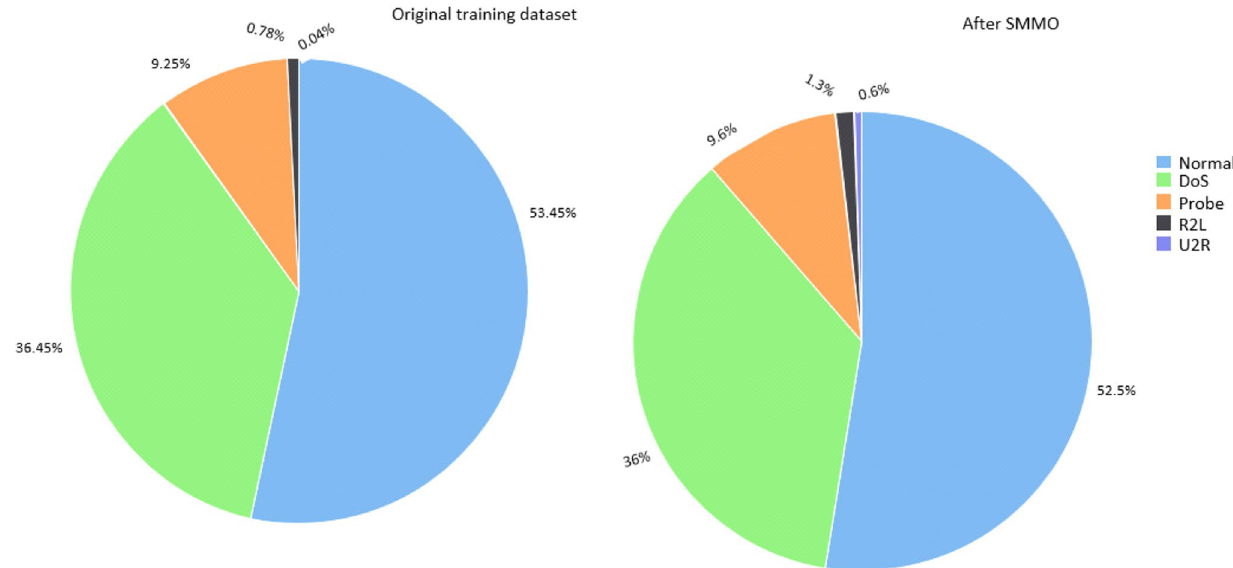
Fig. 3 Distribution of classes for original dataset and after applying Synthetic Multi-minority Oversample (SMMO) Table 3 Performance evaluation of SMMO-CoFS method in terms of TPR, Pr, recall, F 1 and ROC for U2R and R2L classes using random forest and J48 classifiers by comparing with original data set